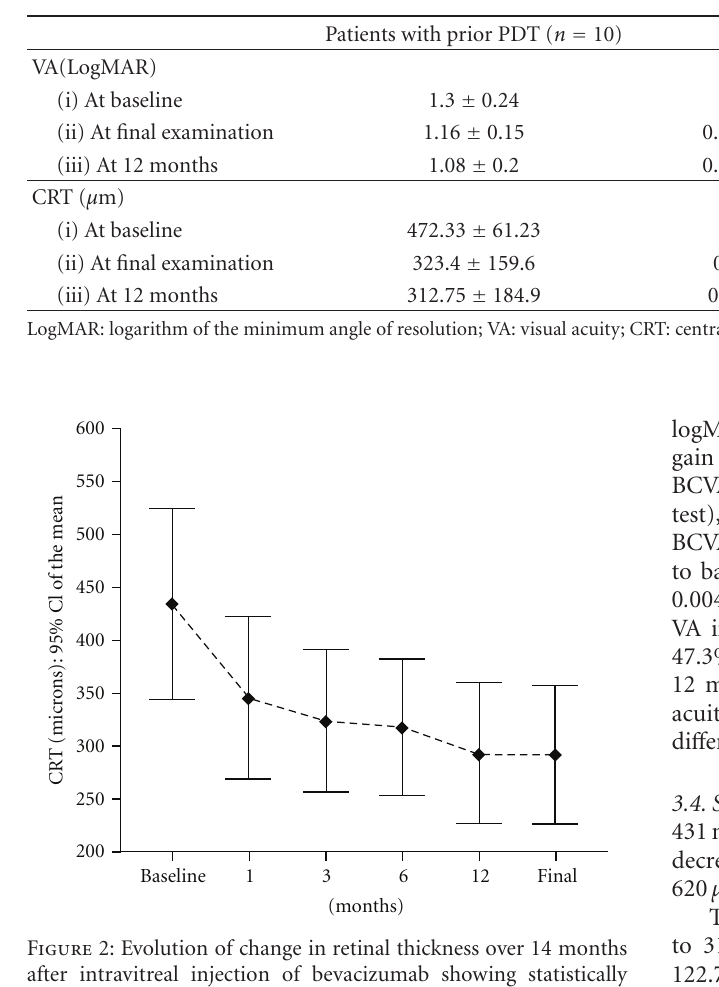
Table 2: Visual acuity (VA) and central retinal thickness (CRT) outcome in patients previously treated with PDT compared with patients without prior PDT.